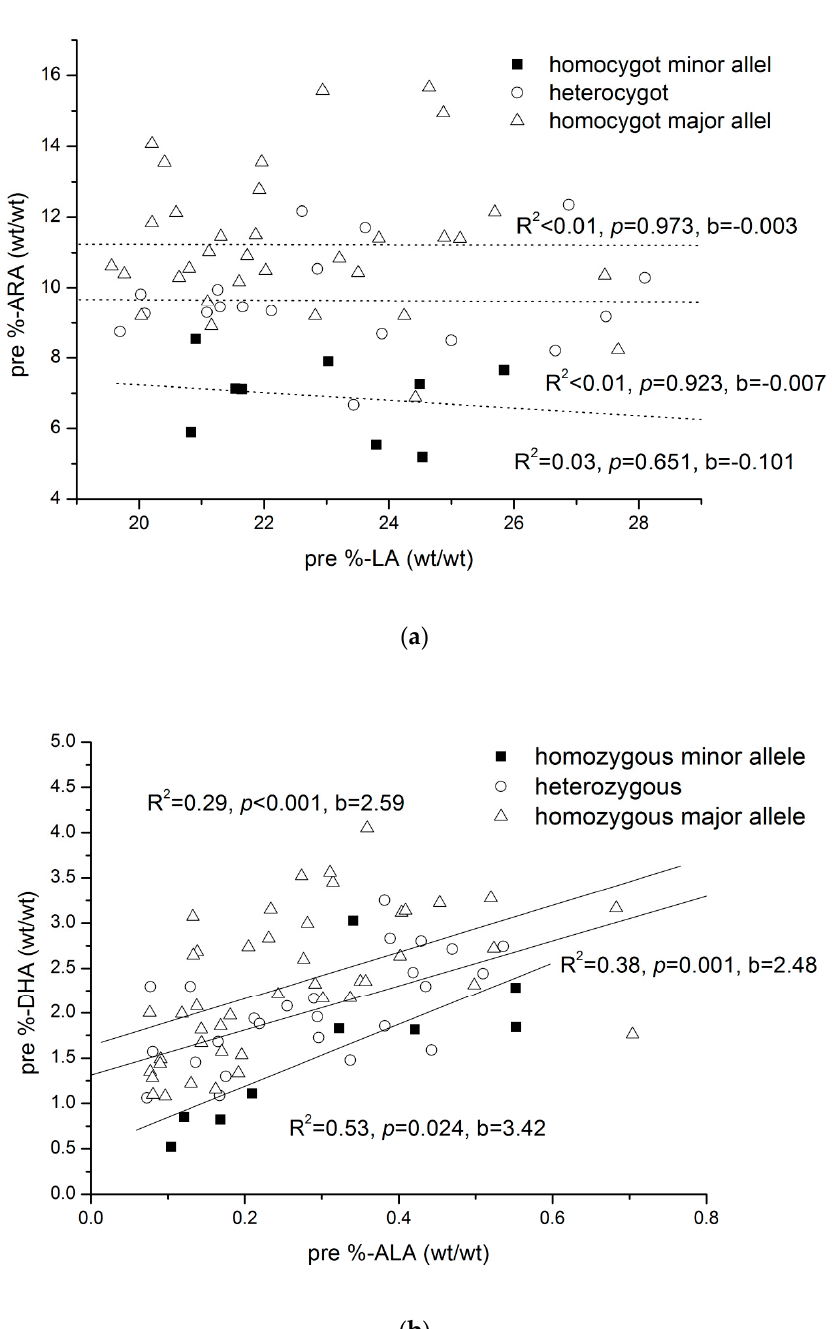
Figure 5. ( a ) Pre study arachidonic acid (%-ARA) percentages versus linoleic acid (%-LA) percentages in glycerophospholipids according to the individual alleles of rs174548; ( b ) Pre study docosahexaenoic acid (%-DHA) percentages versus α -linolenic acid (%-ALA) percentages in glycerophospholipids according to the individual alleles of rs174548.